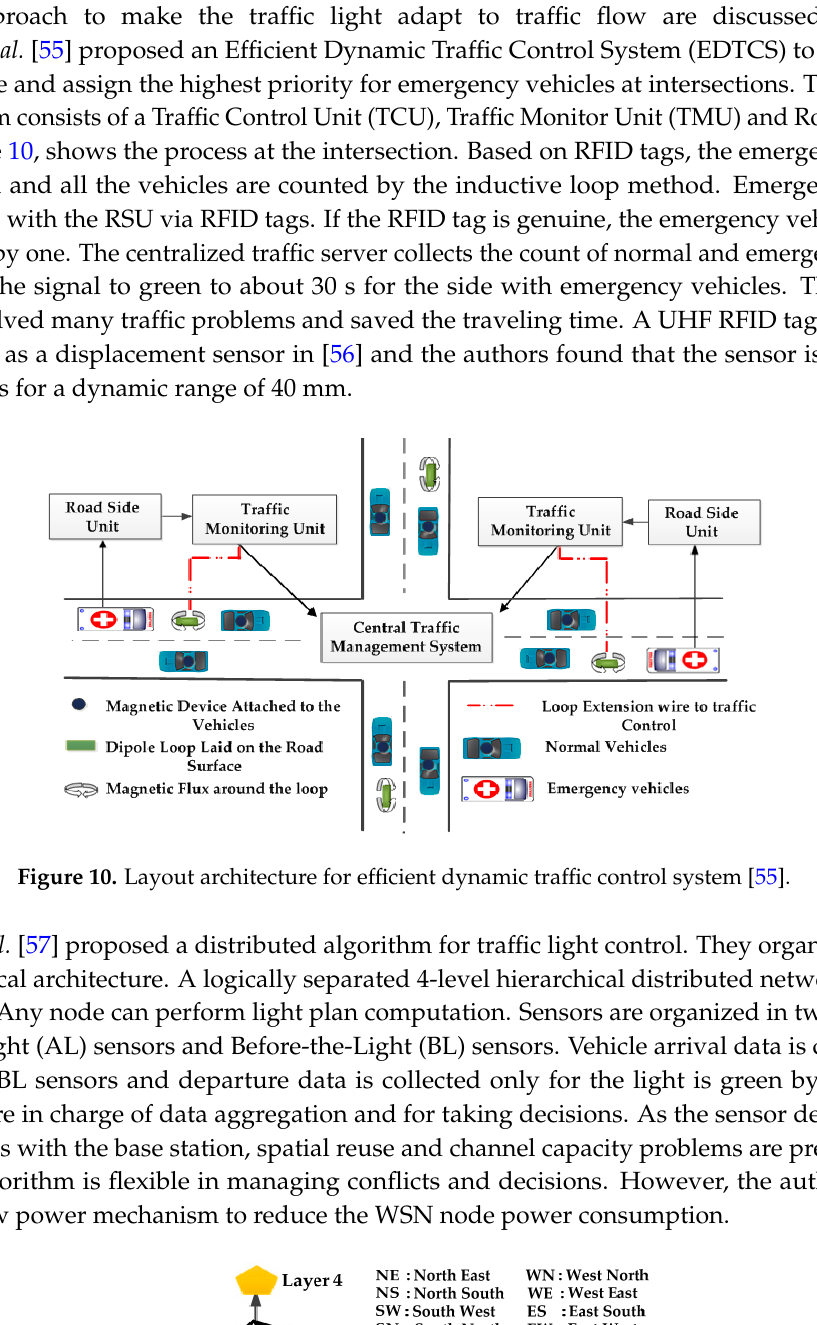
Figure 10. Layout architecture for efficient dynamic traffic control system [55].